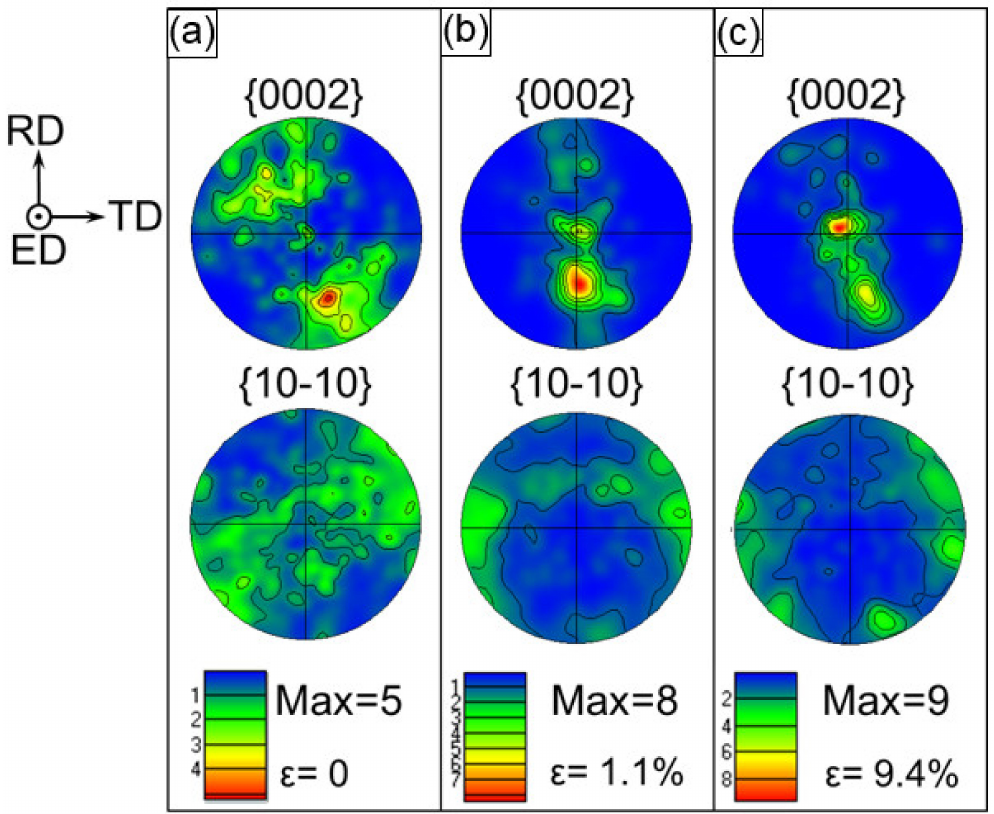
Figure 6. Stereographic pole figures illustrating texture of the WE43 core at di ff erent amounts of true strain at ( a ) 0%, ( b ) 1.1%, and ( c ) 9.4%, where the compression direction is parallel to the